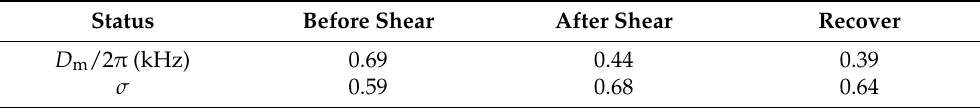
Table 2. D m and σ obtained from the fitting of the corresponding nDQ buildup curves of HTPB28/ C18-clay nanocomposites in different states by assuming a log-normal distribution for D res . Status Before Shear After Shear Recover D m /2 π (kHz) 0.69 0.44 0.39 σ 0.59 0.68